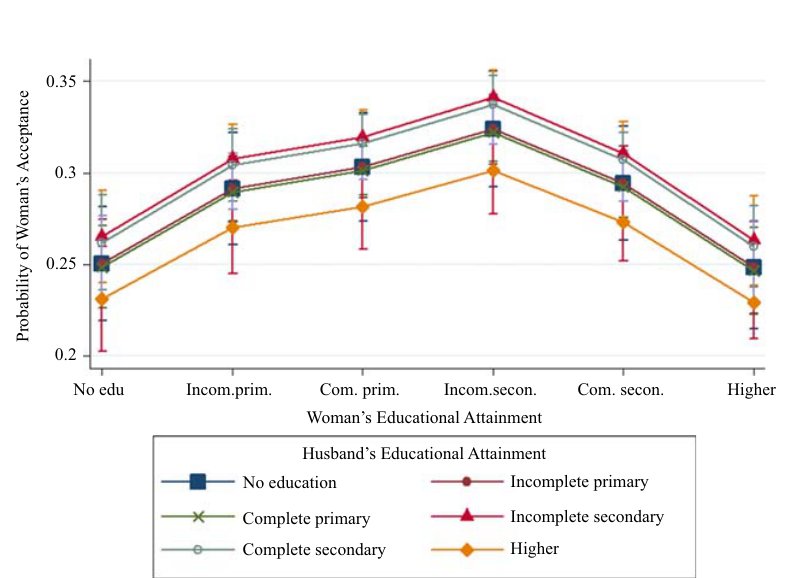
Figure 2. Probability of women ’ s acceptance based on